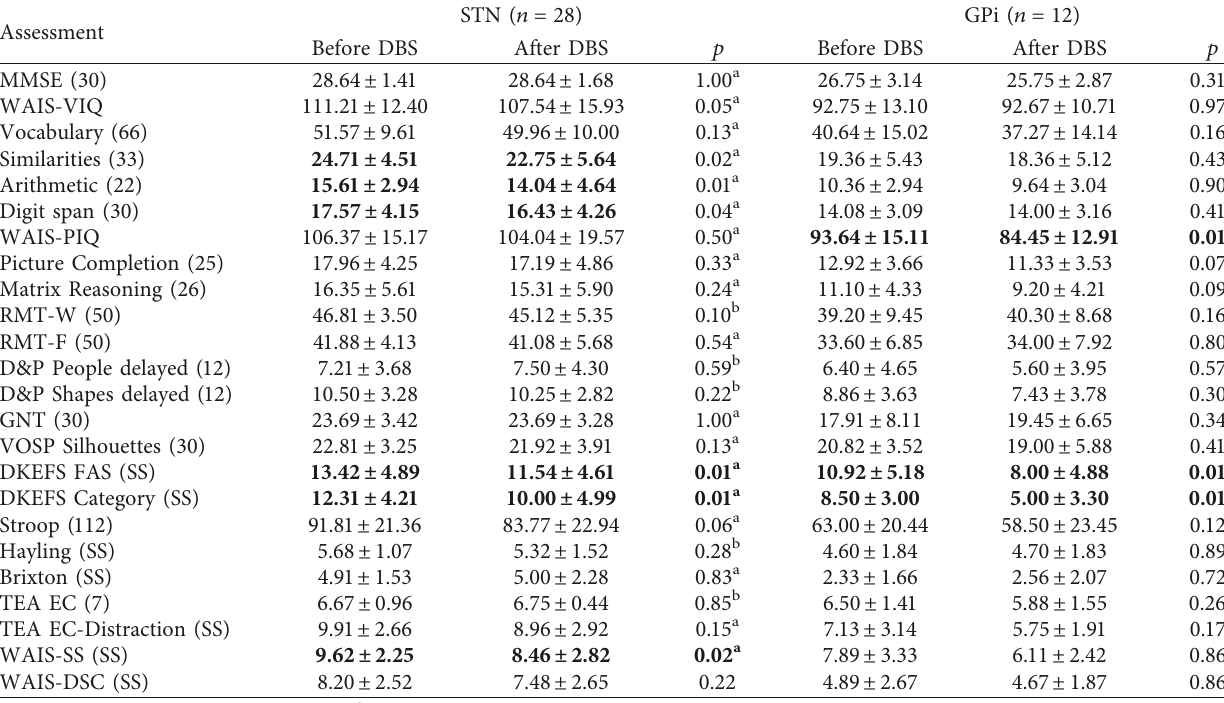
Table 5: Cognitive performance before and after DBS: mean scores on each test.